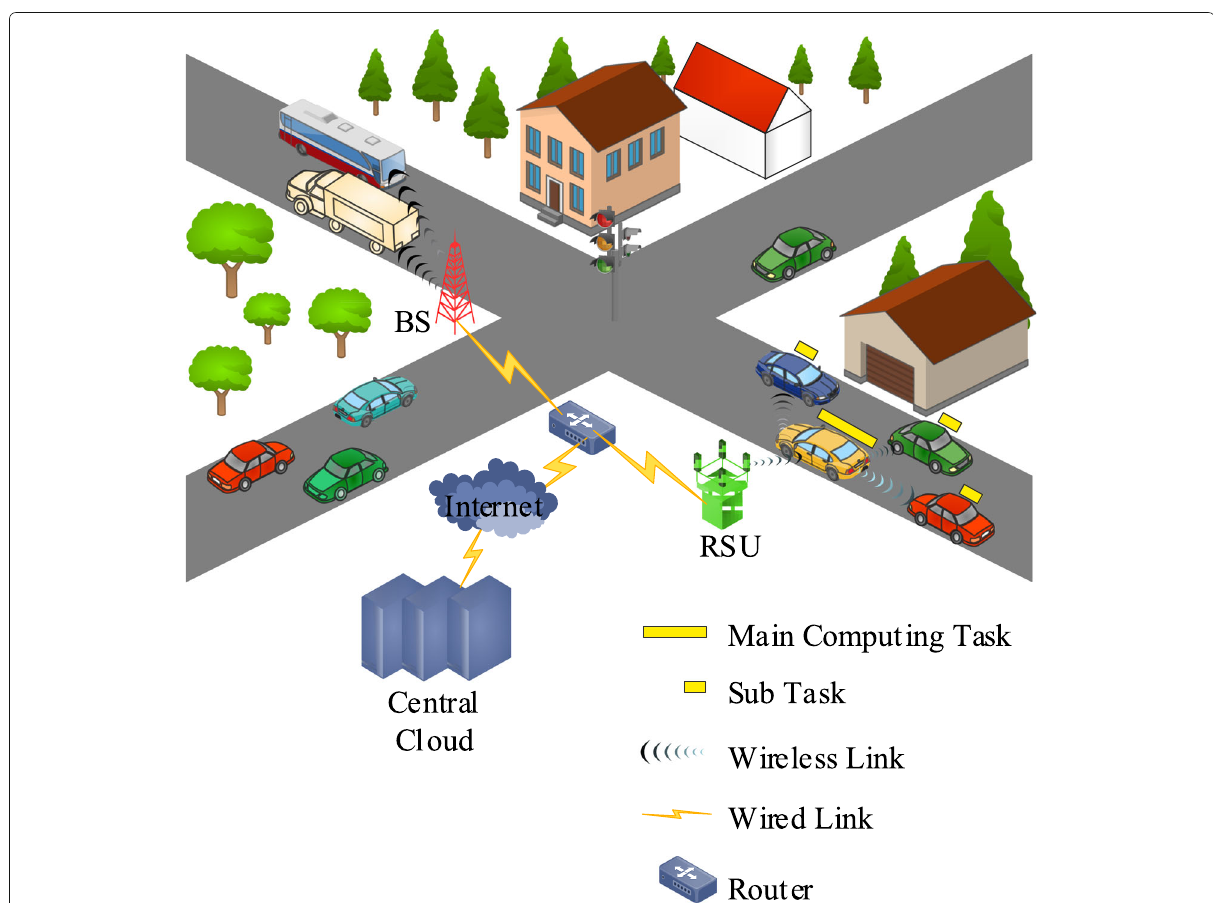
Fig. 3 VCC–Computing as a Service. Usage of vehicular network to support computational